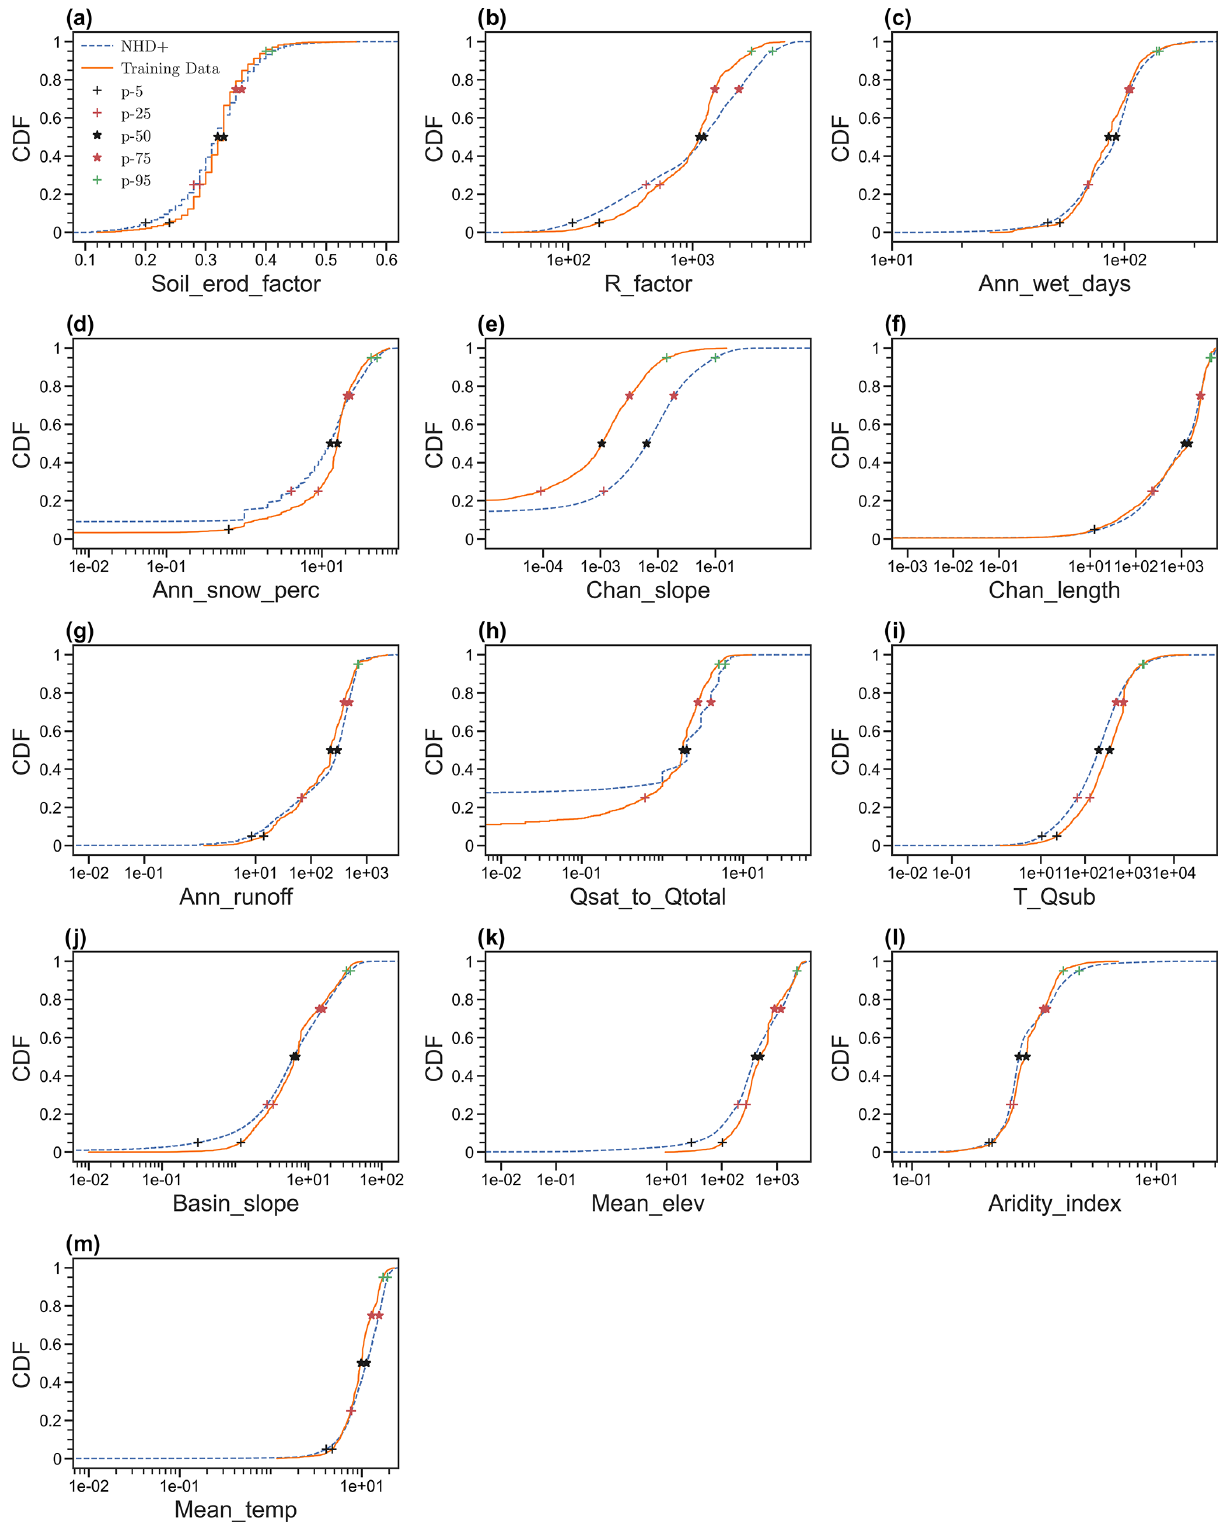
Figure 5. Comparison of the cumulative distribution function (CDF) of 13 features between training data and all flowlines (i.e., NHDPlus).